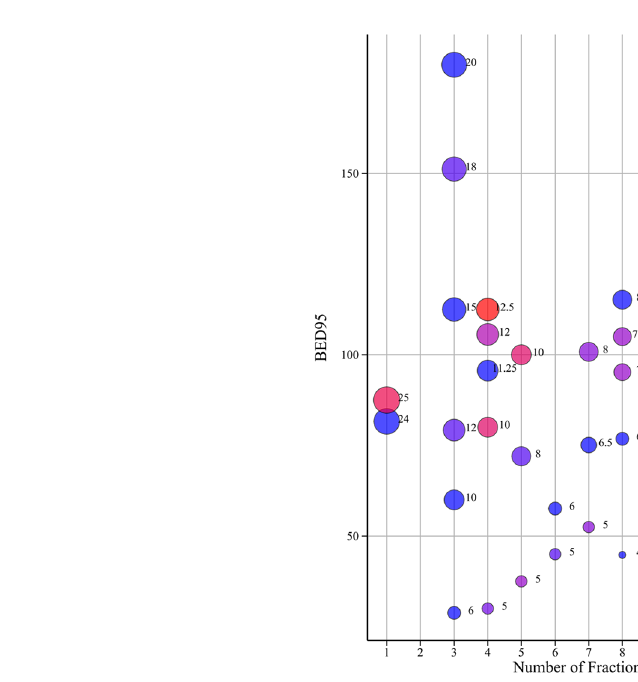
dosimetric parameters based on ROC curve are shown in Table 1 . No signi fi cant association was seen with baseline clinical and dosimetric characteristics in the training group and validation group of tumors. The balance of the two sets of data suggests that the patient grouping was reasonable.